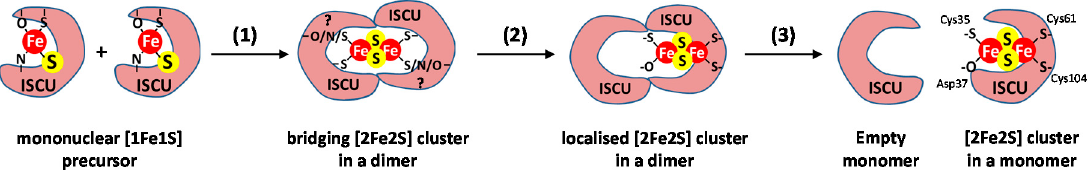
Figure 7. Hypothetic model for the formation of the [2Fe2S] cluster by dimerization of IscU / ISCU. The model for the formation of a [2Fe2S] cluster in Iscu / ISCU is decomposed in three steps: ( 1 ) the dimerization of two ISCUs coordinating a mononuclear [1Fe1S] intermediate generates a bridged [2Fe2S] cluster in a dimer of ISCU, ( 2 ) the [2Fe2S] segregates on one monomer and ( 3 ) the dimer dissociates to yield an empty monomer and a monomer containing the [2Fe2S] cluster. In the monomer, the [2Fe2S] cluster is coordinated by Cys35, Asp37, Cys61 and Cys104 of ISCU.